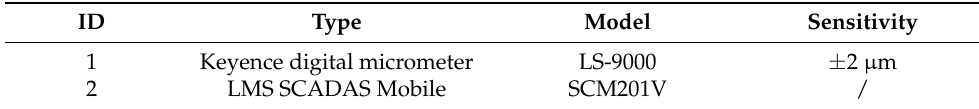
Table 1. The instruments’ parameters used in the measurement device. ID Type Model Sensitivity 1 Keyence digital micrometer LS-9000 ±2 μ m 2 LMS SCADAS Mobile SCM201V /